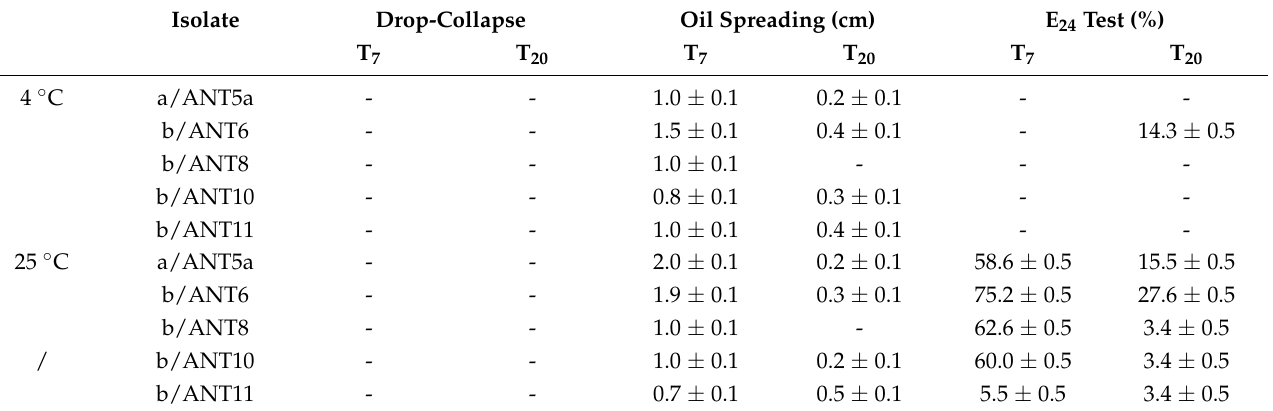
Table 2. Biosurfactant production (by Drop-collapse and oil spreading tests) and emulsification activity (%, E24) of the studied strains found at 4 and 25 ◦ C and after 7 (T7) and 20 (T20) days